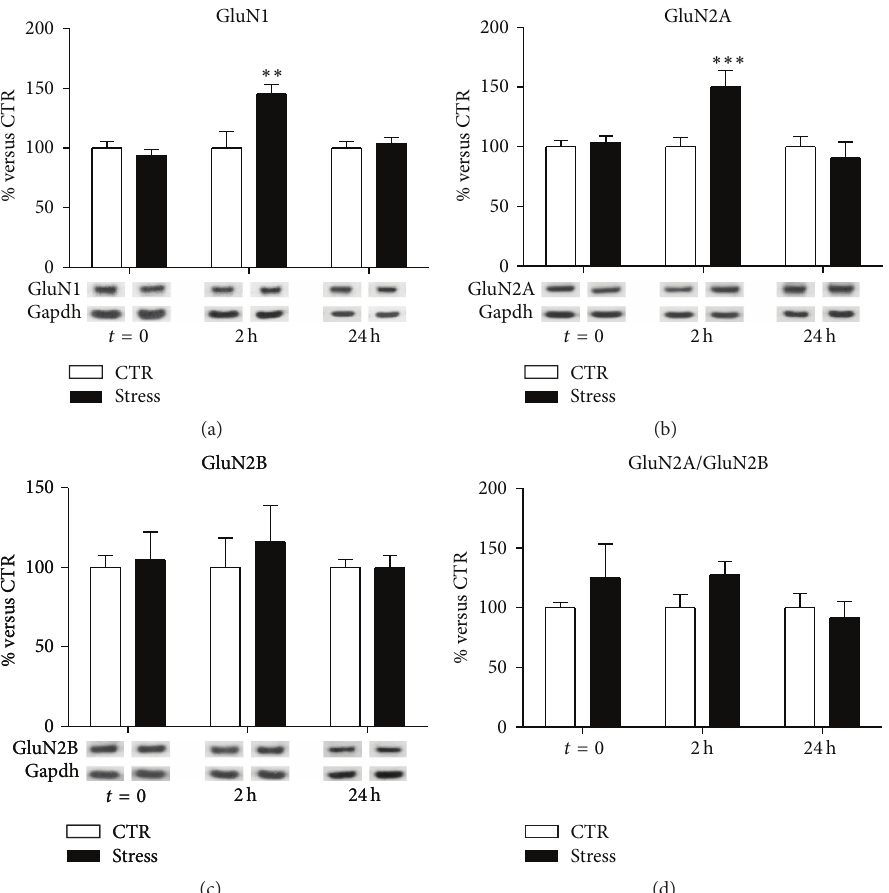
Figure 4: Time-dependent changes of protein expression levels of GluN1 (a), GluN2A (b), GluN2B (c), and GluN2A/GluN2B (d) in PFC/FC postsynaptic spine membranes of rats subjected to FS-stress and sacrificed immediately after stress and 2 h and 24 h from stress beginning. Data are represented as percentage of controls at each time point, as means ± SEM ( 𝑛 = 8 ). Statistics: Generalized Linear Models (GLM) and Bonferroni Post Hoc Test (see Section 2 for details). ∗∗ 𝑝 < 0.01 ; ∗∗∗ 𝑝 < 0.001